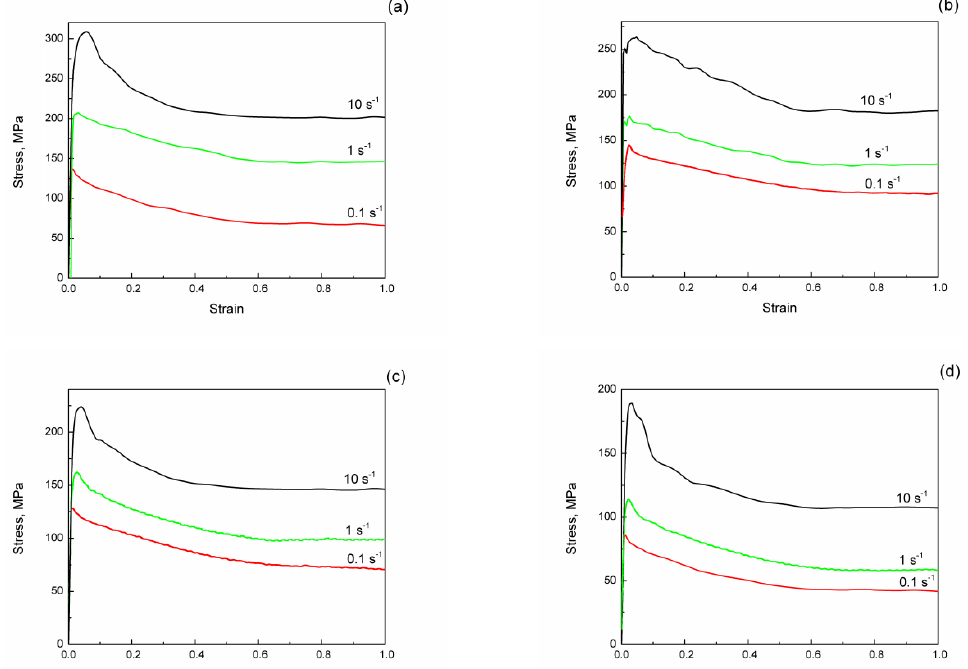
Figure 4. Stress–strain curves of the Fe–16Cr–4Ti–6Zr–3.2B steel at temperatures of 1273 K ( a ), 1323 K ( b ), 1373 K ( c ) and 1423 K ( d ).